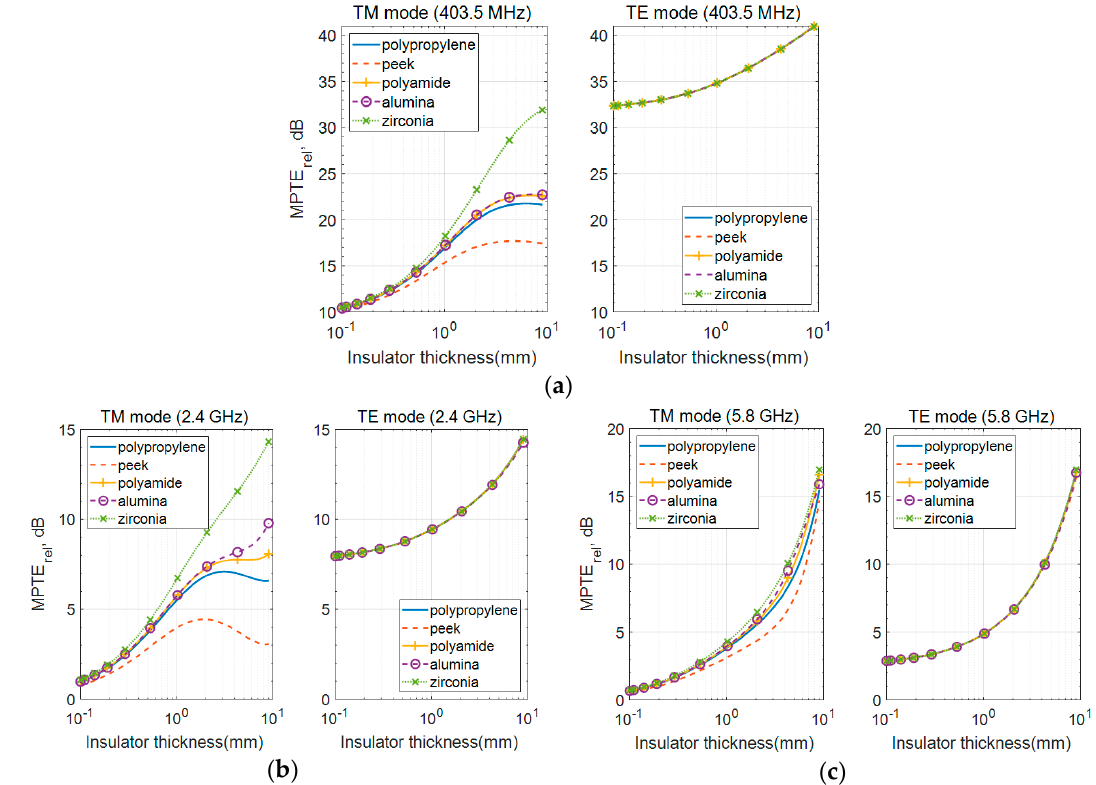
Figure 4. MPTE rel results with different commercially available biocompatible materials as the Figure4. MPTE rel resultswithdi ff erentcommerciallyavailablebiocompatiblematerialsastheinsulating insulating layer: ( a ) 403.5 MHz; ( b ) 2.4 GHz; ( c ) 5.8 GHz. layer: ( a ) 403.5 MHz; ( b ) 2.4 GHz; ( c ) 5.8